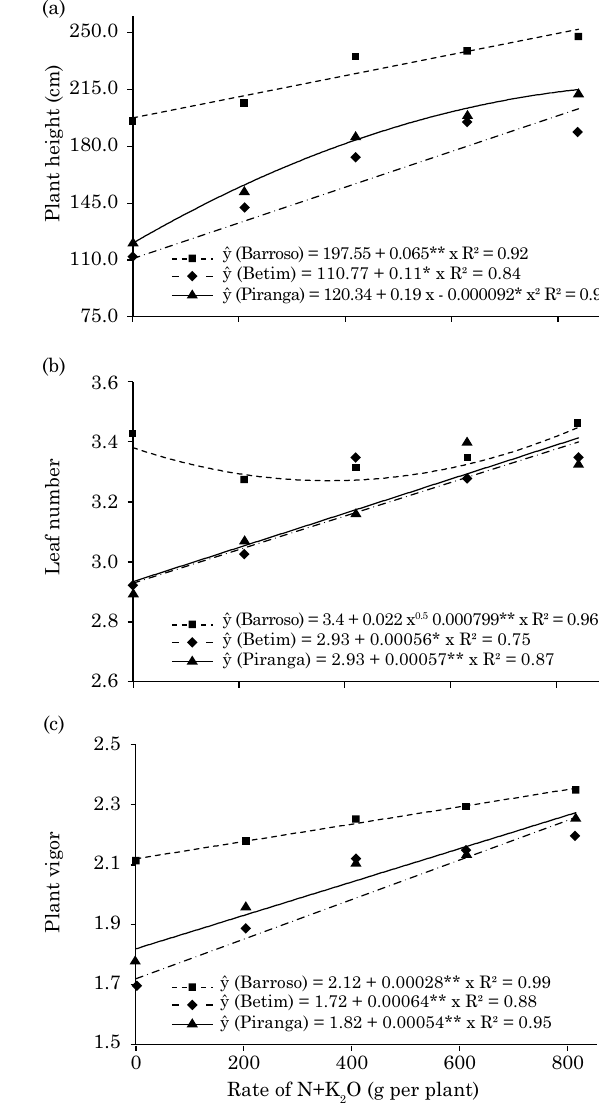
figure 2. Plant height (a), plant vigor (b) and leaf number (c) of plants of three macaw genotypes in the second year of field cultivation in response to N+K rates. **: significant at 1 % by the t